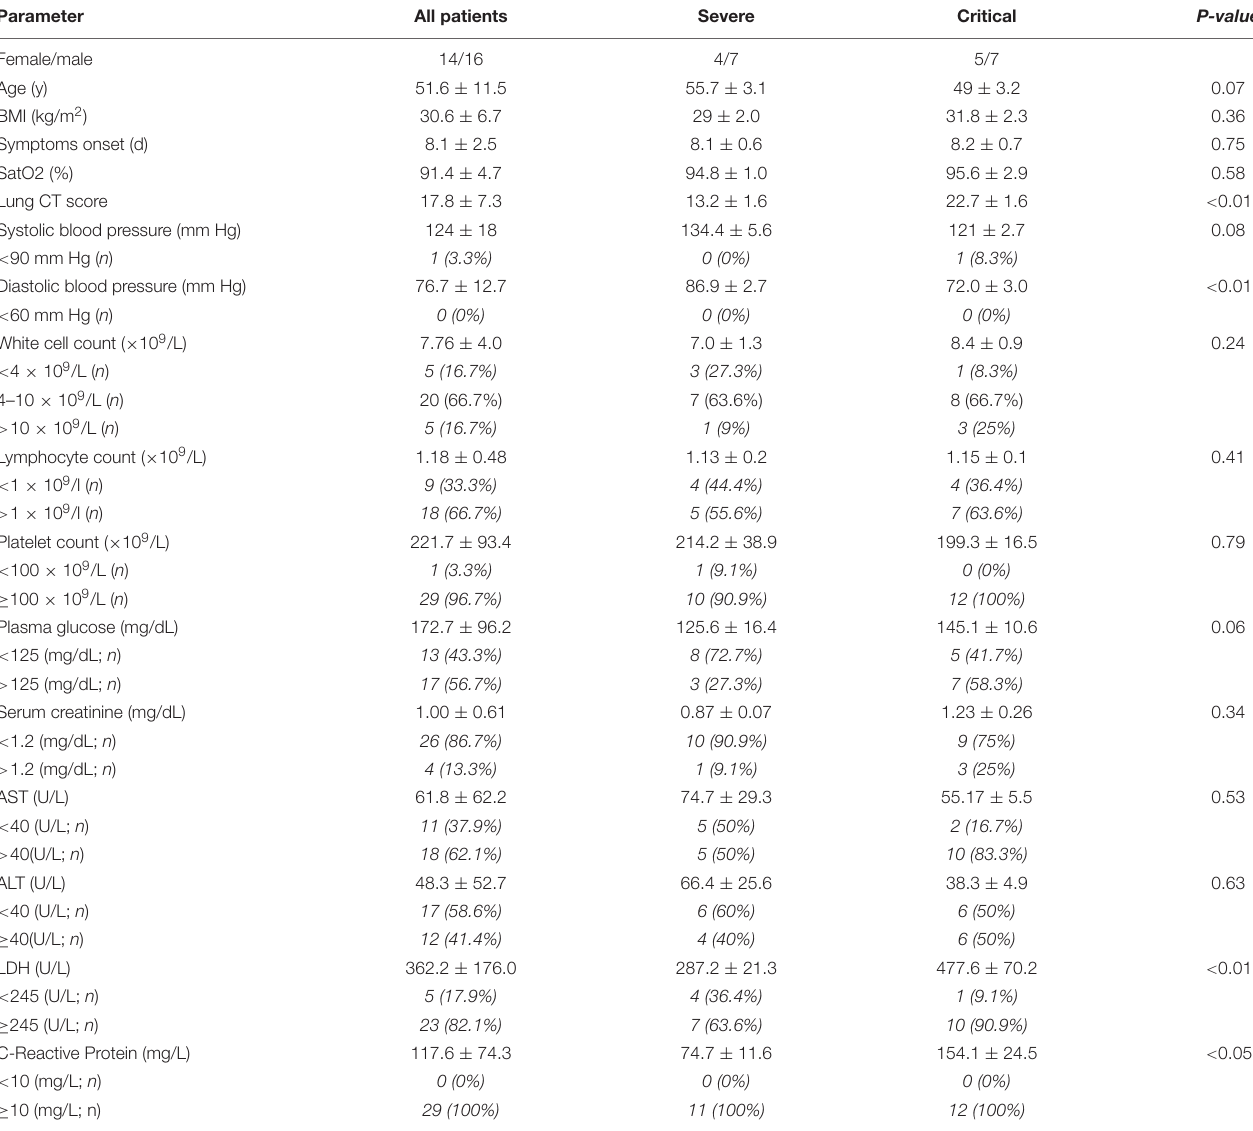
TABLE 1 | Clinical and laboratorial parameters at